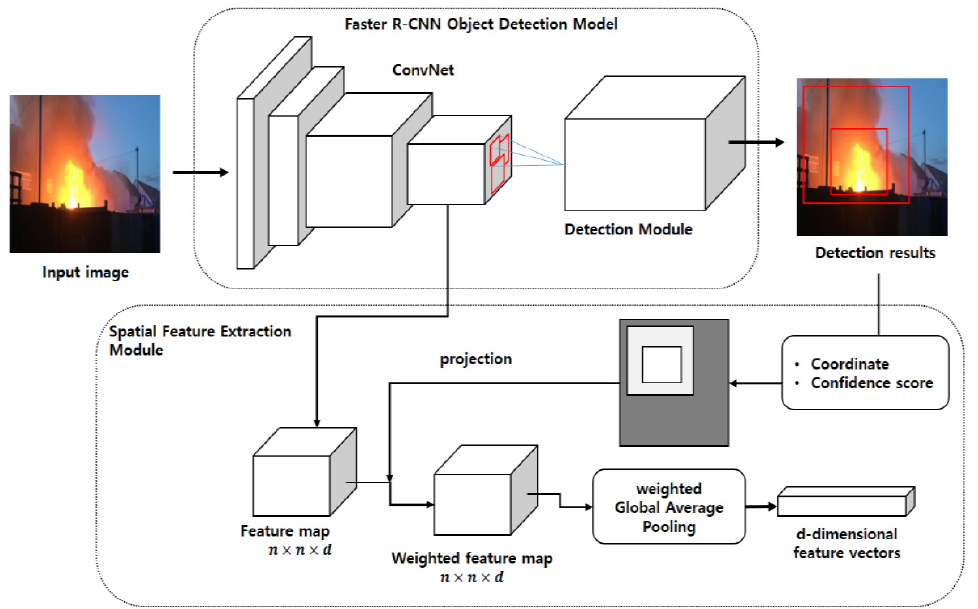
Figure 5. The spatiotemporal feature extraction from Faster R-CNN [26].